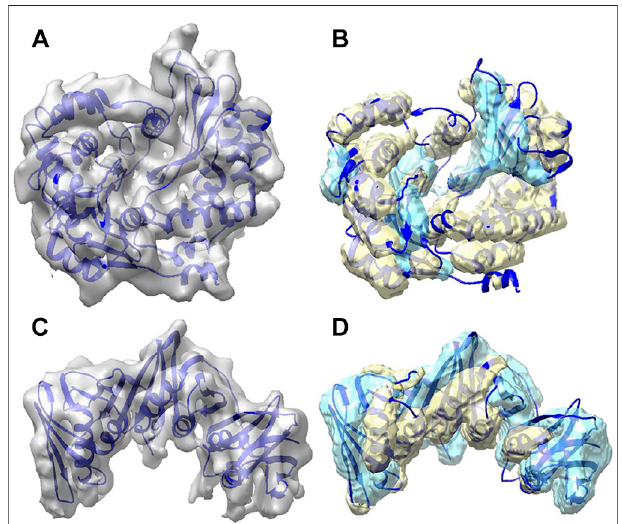
FIGURE 2 | Segmentation of secondary structures using DeepSSETracer0.1fortwochains. (A) Thecryo-EMdensitymap(EMD-8129, grey) component corresponding to the atomic structure of chain AA of 5j8k (PDB ID, blue ribbon). (B) Helix regions (yellow) and β -sheet regions (cyan) that were detected from the component map in (A) are overlayed with the atomic structure. (C) The cryo-EM density map (EMD-4141, grey) component corresponding to the atomic structure of chain B of 5m1s (PDB ID, blueribbon). (D) Helixregions(yellow) and β -sheetregions(cyan)thatwere detected from the component map in (C) using DeepSSETracer 0.1. The display was created using Chimera (Pettersen et al., 2004).